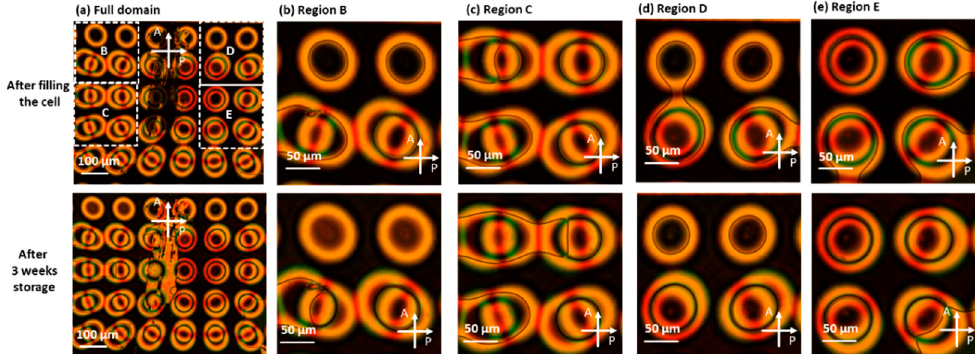
Figure 2. Microscope images of the cell (0V) in a patterned area where the centra of the patterned rings at the top and bottom substrate overlap at some positions. An overview of a larger area, with a scratch in the middle, is shown in ( a ) and an enlarged view of four different regions is shown in ( b ), ( c ), ( d ) and ( e ) respectively. The dimensions of the patterned rings are r out = 50 µm (r in = 0.4 * r out ). The transmission is show for the cell between crossed polarizers aligned with the x- and y-axis. The first row shows images of the cell measured shortly after preparing the cell, the images in the second row were measured after 3 weeks.